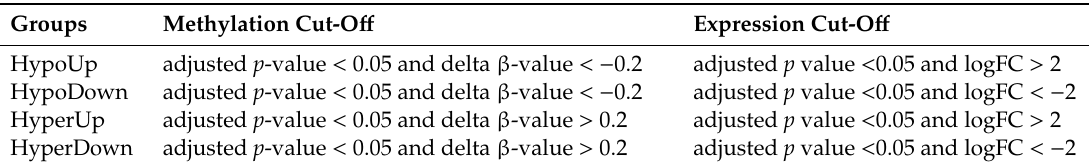
Table 1. The measurable cuto ff of four